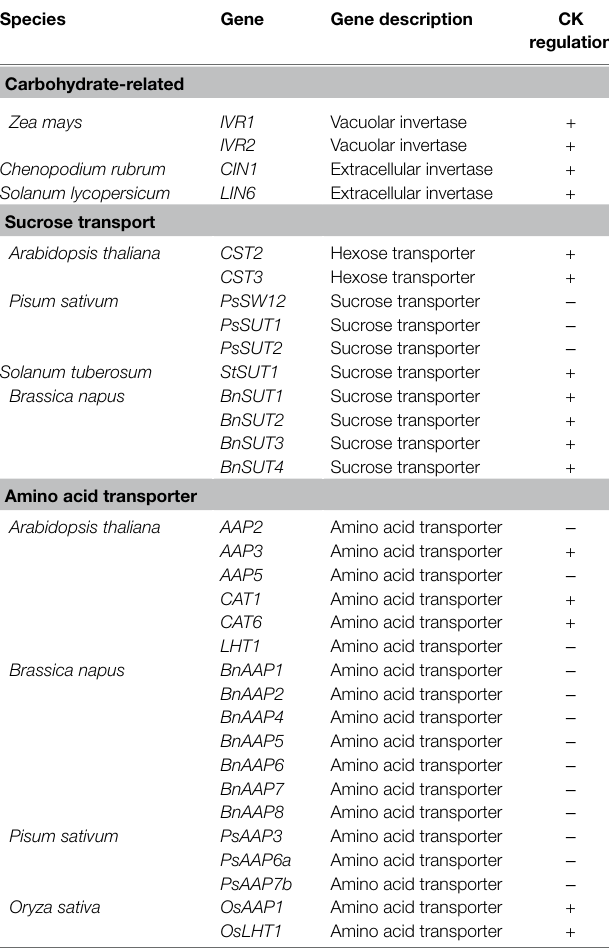
TABLE 1 | Transcriptional regulation by cytokinins of genes encoding invertases, sugar, and amino acid transporters in various plant species.